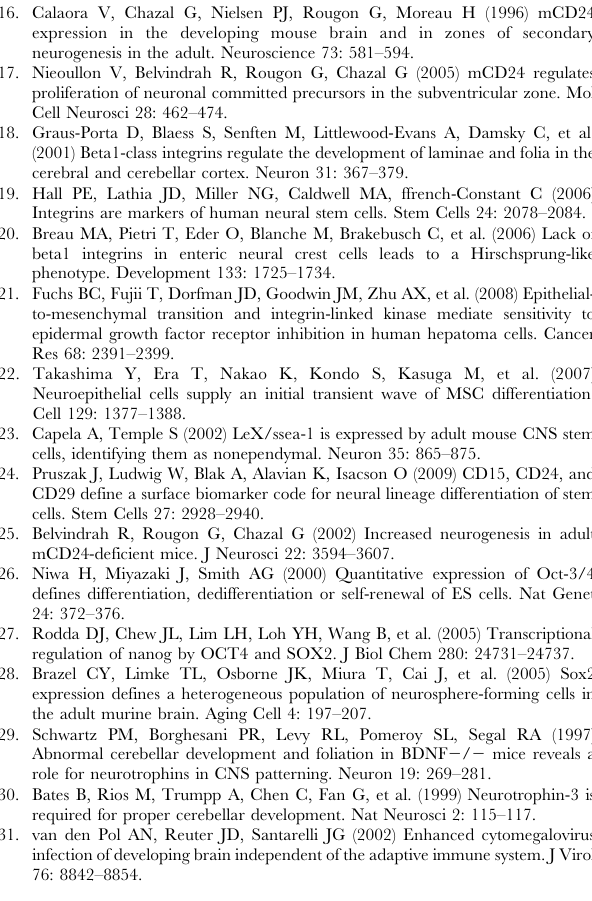
Figure S2 Neonatal mice fail to control viral brain infection. Day-old littermates were injected intracranially with MCMV (500 or 200 TCID 50 in 2 m l) or with saline. The infected and control neonates were nourished in identical conditions. Data are expressed as percent survival in each group at the indicated time point, followed over the 15 d time-course of the experiment.